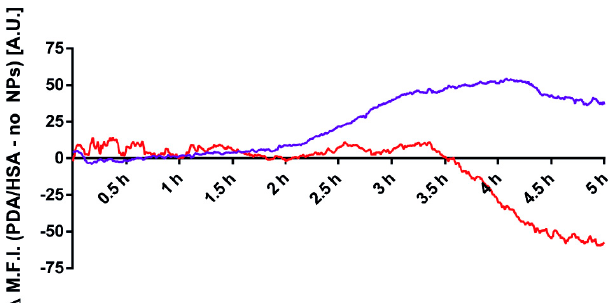
Figure 4. The ∆ mean fluorescent intensity (M.F.I.) of the green fluorescent signals shown in Figure 3 are presented as the normalized mean fluorescent intensity, per region, and the values from the negative control results were subtracted.